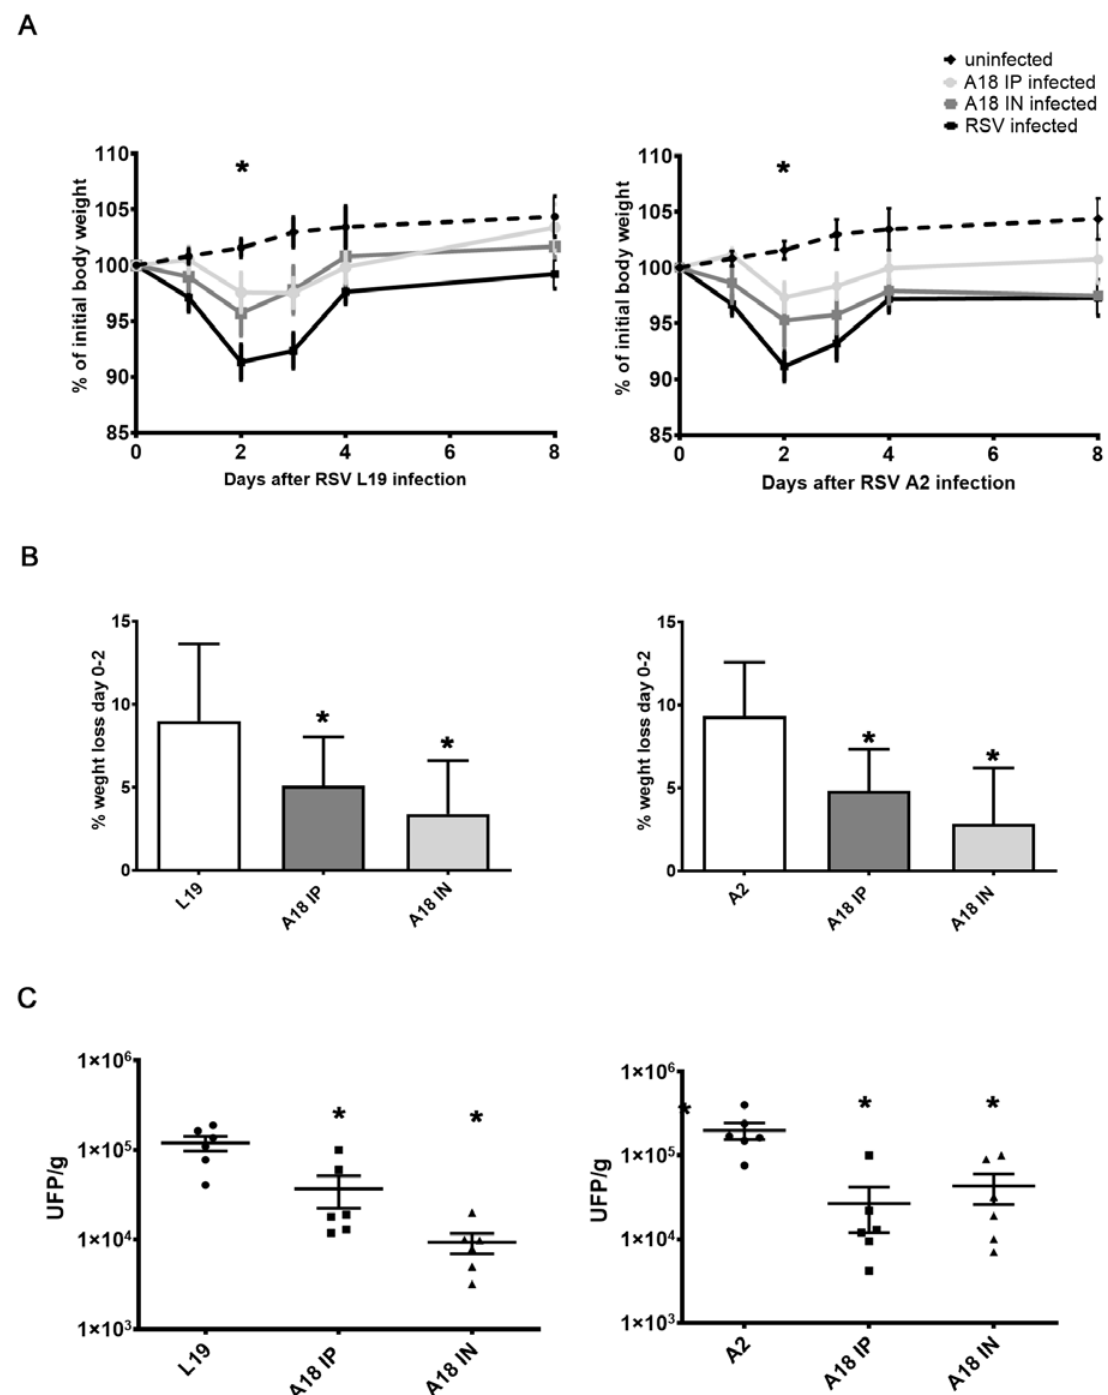
Figure 5. In vivo evaluation of A18 antiviral effect. Female Balb/c mice were infected with RSV line 19 and A2 (5 × 10 6 PFU) by intranasal instillation, concomitant with 6 mg/kg of A18 i.p. or 3 mg/kg of A18 by i.n. injection on day 0. On days 1–4, all mice received further inoculations of A18 i.p. or i.n. ( A , B ) Weight was monitored and assessed as a percentage of starting weight. Day 0 refers to the time right before inoculation. * At day 2, values for A18-treated infected mice were significantly higher than infected mice ( p -value < 0.05). ( C ) The animals were killed on day 4 and the lungs were used for titration of infectious virus. Data show mean ± SD from n = 6 mice/condition. * Significantly different from RSV-infected mice ( p -value < 0.05).